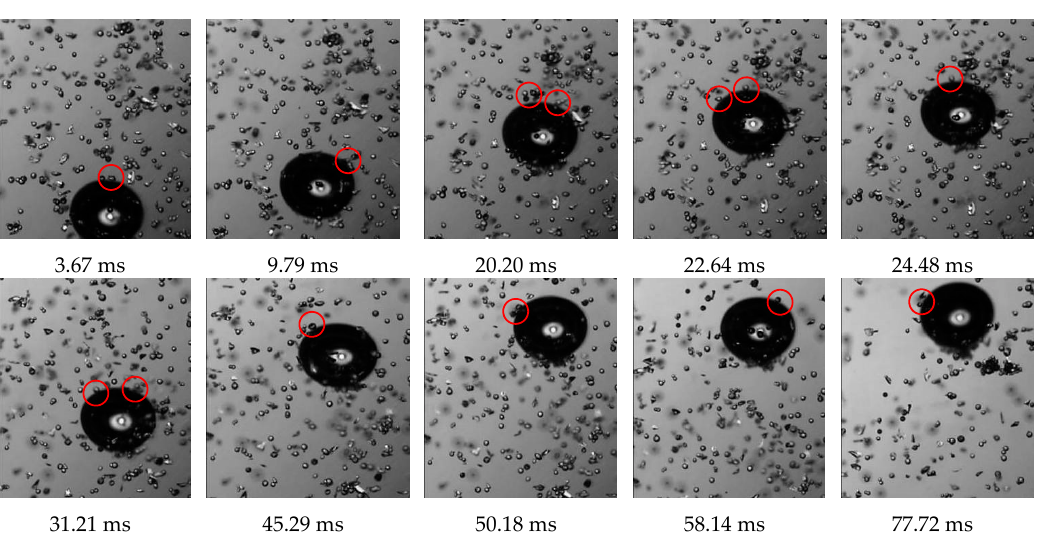
Figure 9. Collision between glass microspheres and bubbles.